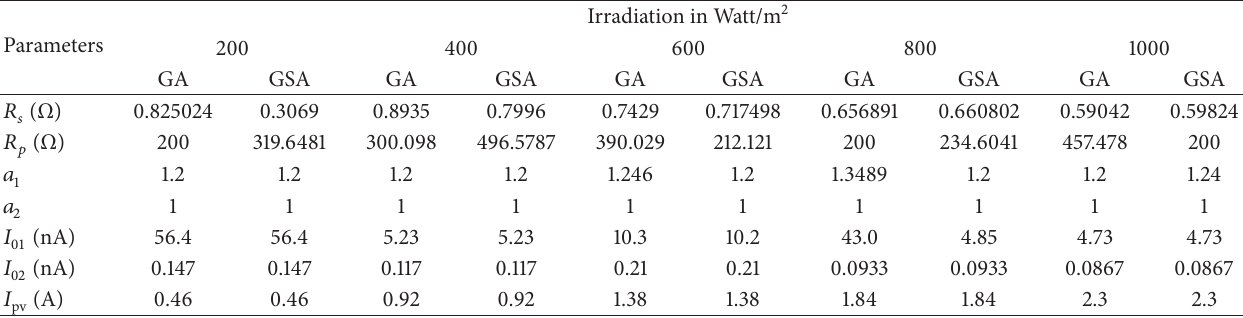
Table 1: Comparison of optimization results of GA and GSA at different irradiation levels for Shell S36.